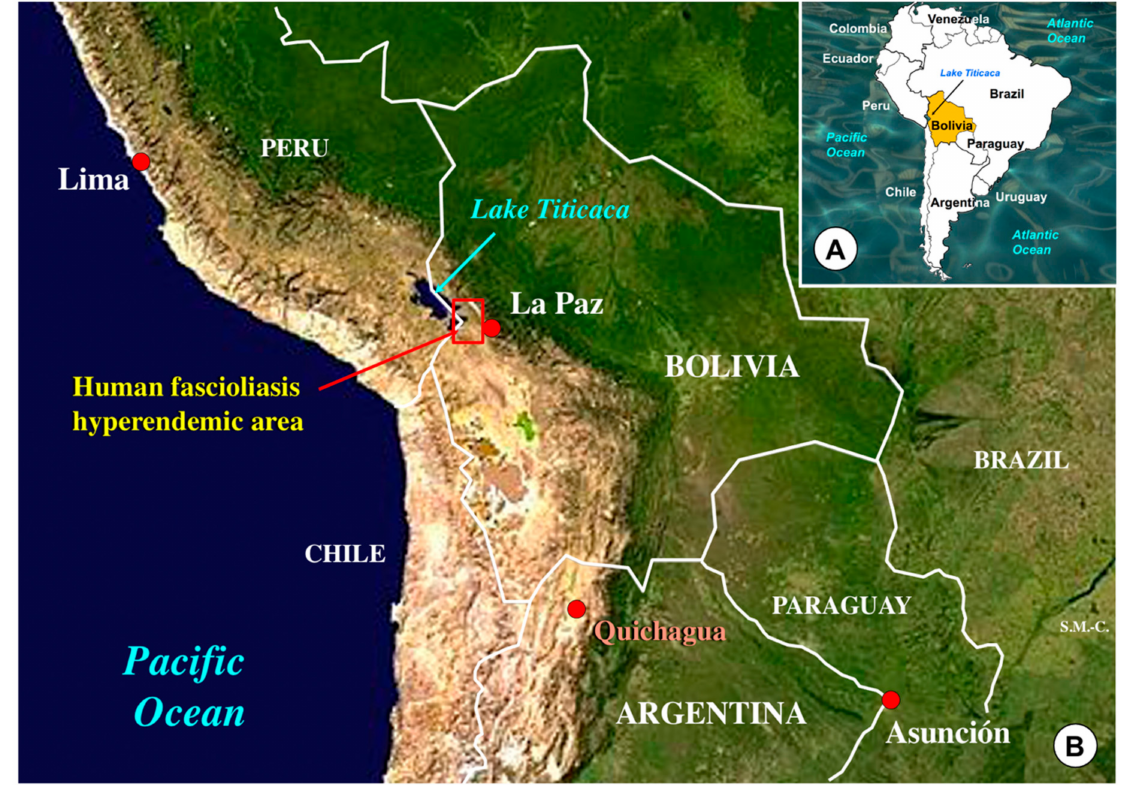
Figure 2. Map showing the locality of Quichagua in the Andean high plateau, at 3586 m altitude in the North of Argentina where Fasciola hepatica materials were collected from llamas, and the human fascioliasis hyperendemic area, in the Northern Altiplano of Bolivia, at 3820–4100 m altitude, where lymnaeid snail vector specimens of Galba truncatula were collected. Background for ( B ) from composed satellite map of South America orthographic projection by NASA (full resolution of 1215 Å ~ 1712 pixels; public domain) via Wikimedia Commons. ( A , B ), originals S.